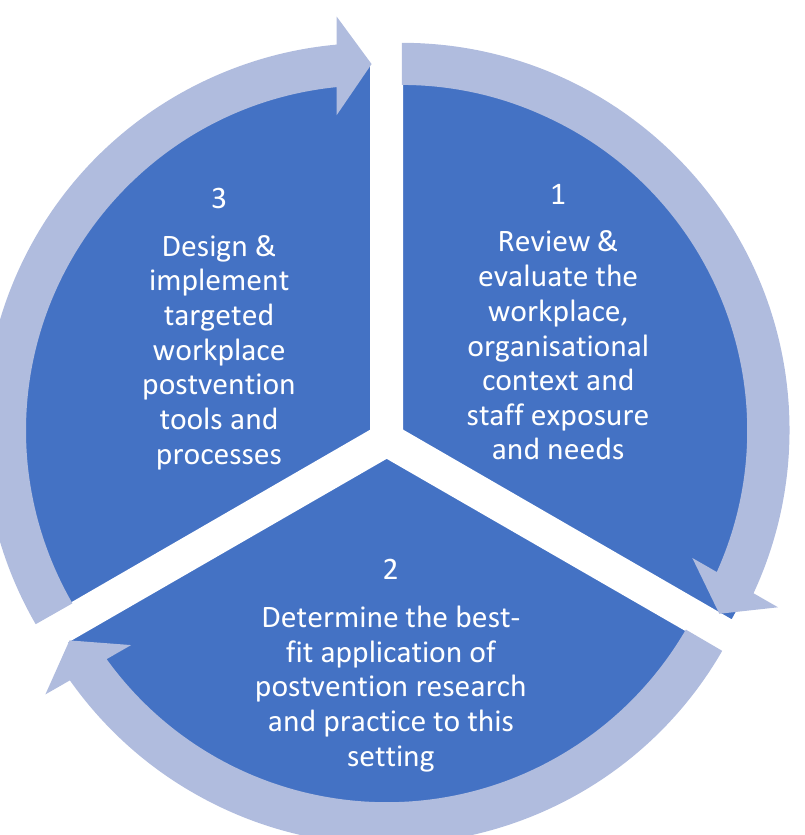
Figure 1. A Public Health Approach to Workplace Postvention (2022).